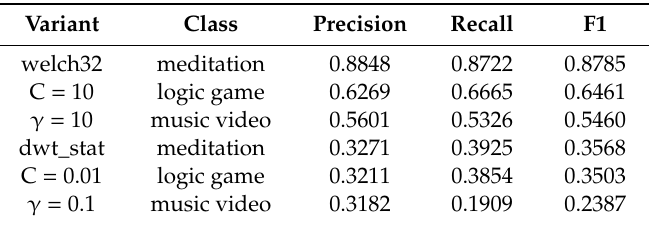
Table 21. Values of precision, recall, and F1 score for 10-fold cross-validation for the best and worst results of the training / validation / test scheme as contained in Table